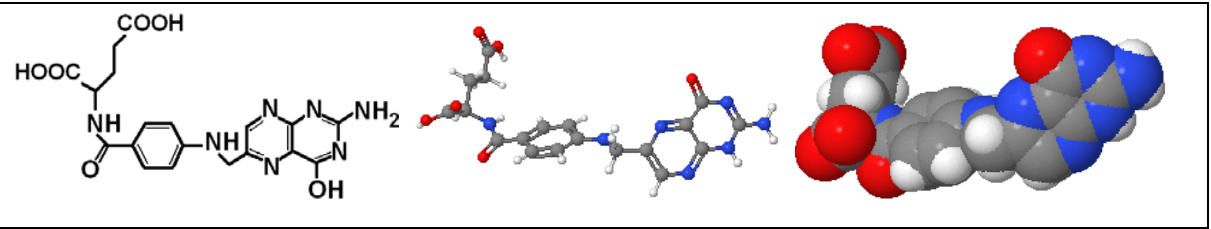
Figure 1. The molecular structure of folic